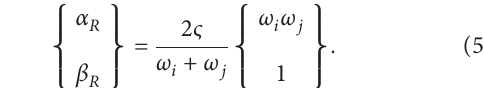
Figure 11: Convergence of the relative error in the horizontal displacement at the monitoring